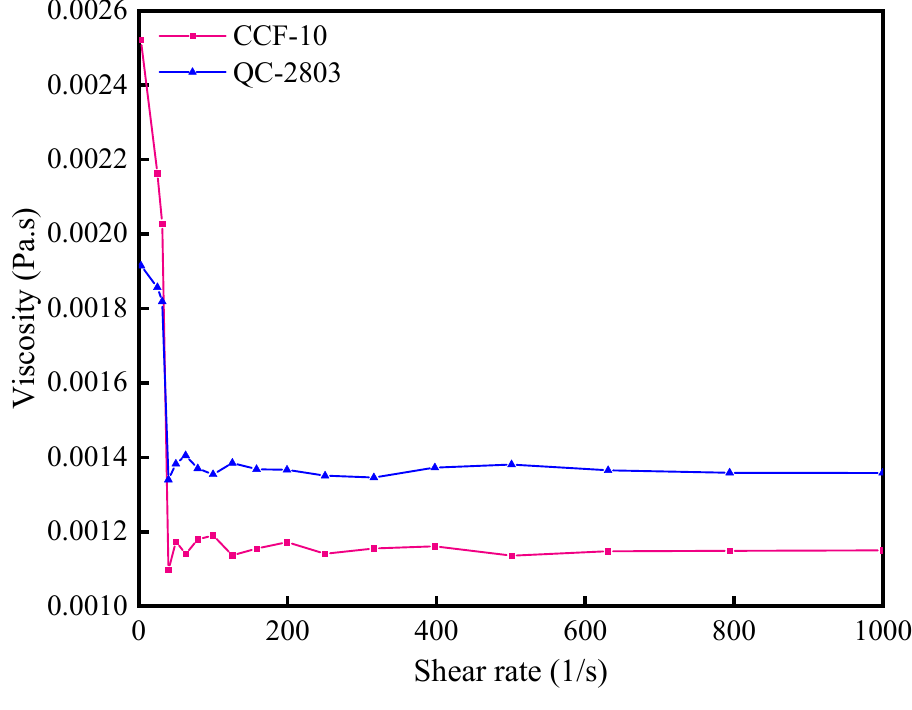
Figure 2. Viscosity of QC-2803 and CCF-10.